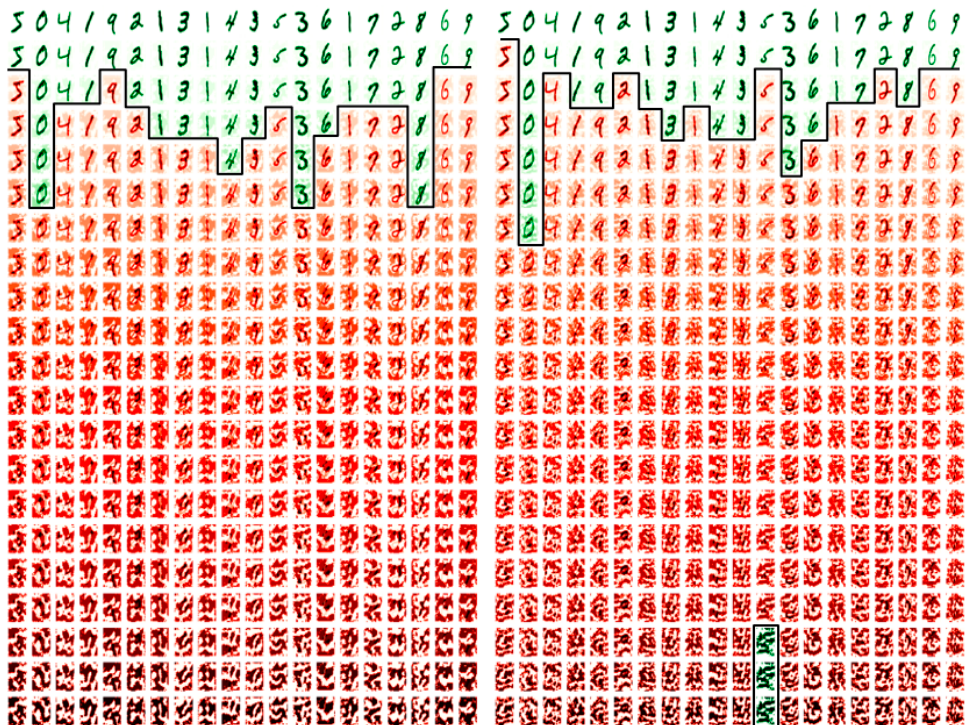
Figure 11. First 20 images of the FSGM attack image examples: using the existing method ( left ) and the proposed method ( right ).